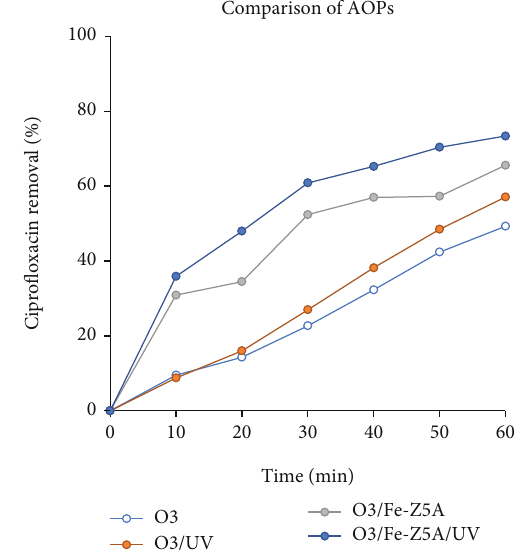
Figure 5: Comparison of AOPs for the removal of cipro fl oxacin ( C o ð = 50 mg/L ; pH = 6 : 5 ± 0 : 2 ; O cipro Þ catalystdose = 25 g : T = 60 min